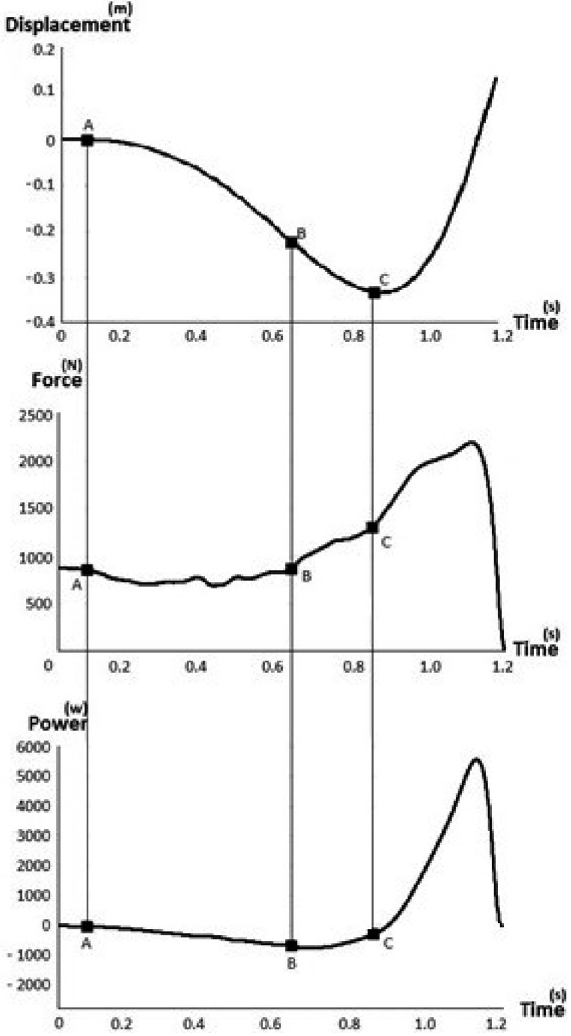
Figure 2. Identification of CMJ phases in displace- ment-time, F-T, and power-time